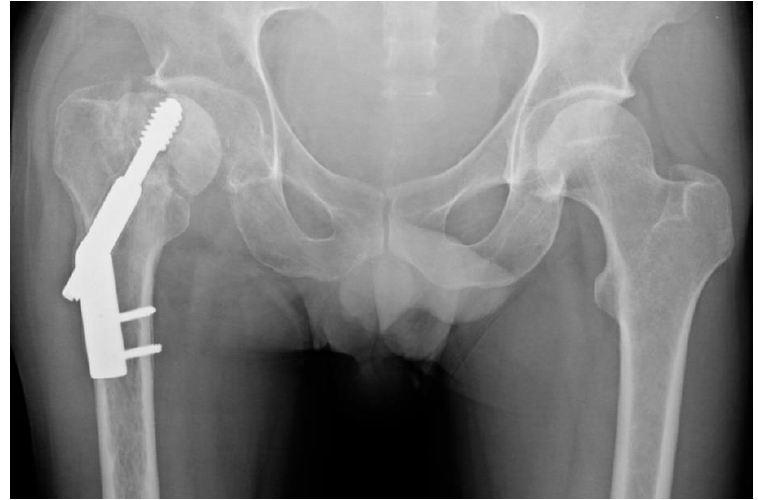
Figure 5. Secondary displacement as a result of avascular necrosis (AVN) after DHS implantation in anteroposterior view. Table 2. Incidence of post-operative complications.